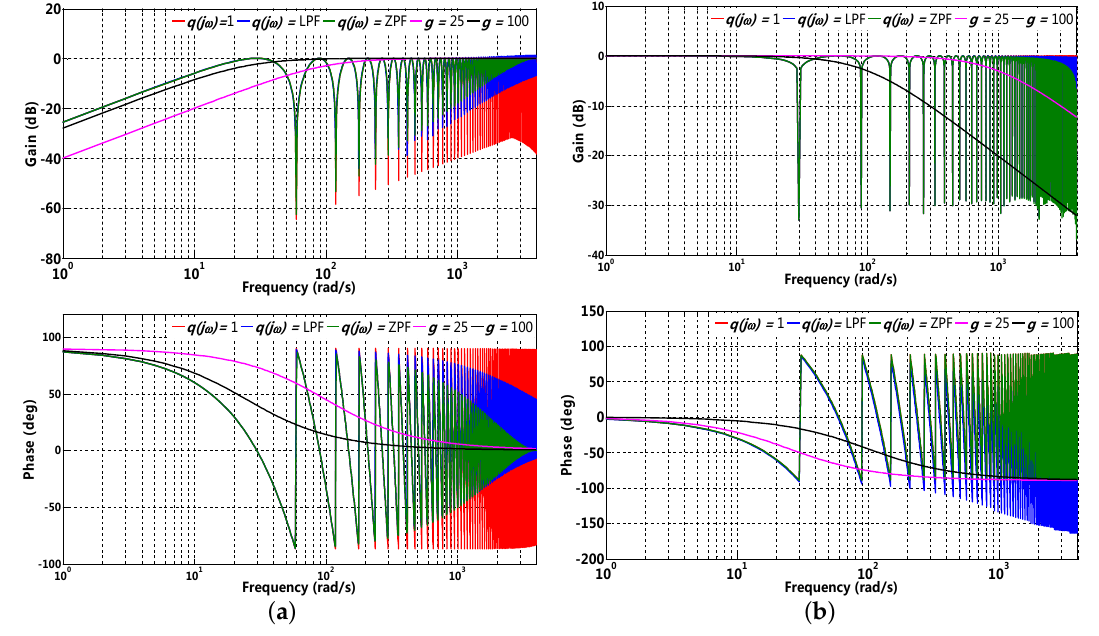
Figure 8. Frequency characteristics with respect to general DOB and PDOB: ( a ) 1 − Q ( z − 1 ) z − m ; ( b ) Q ( z − 1 )